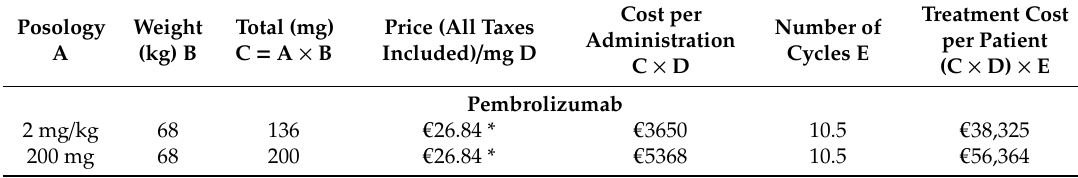
Table 3. Annual cost calculation of treatment with pembrolizumab for patients treated in the 1st line. Posology